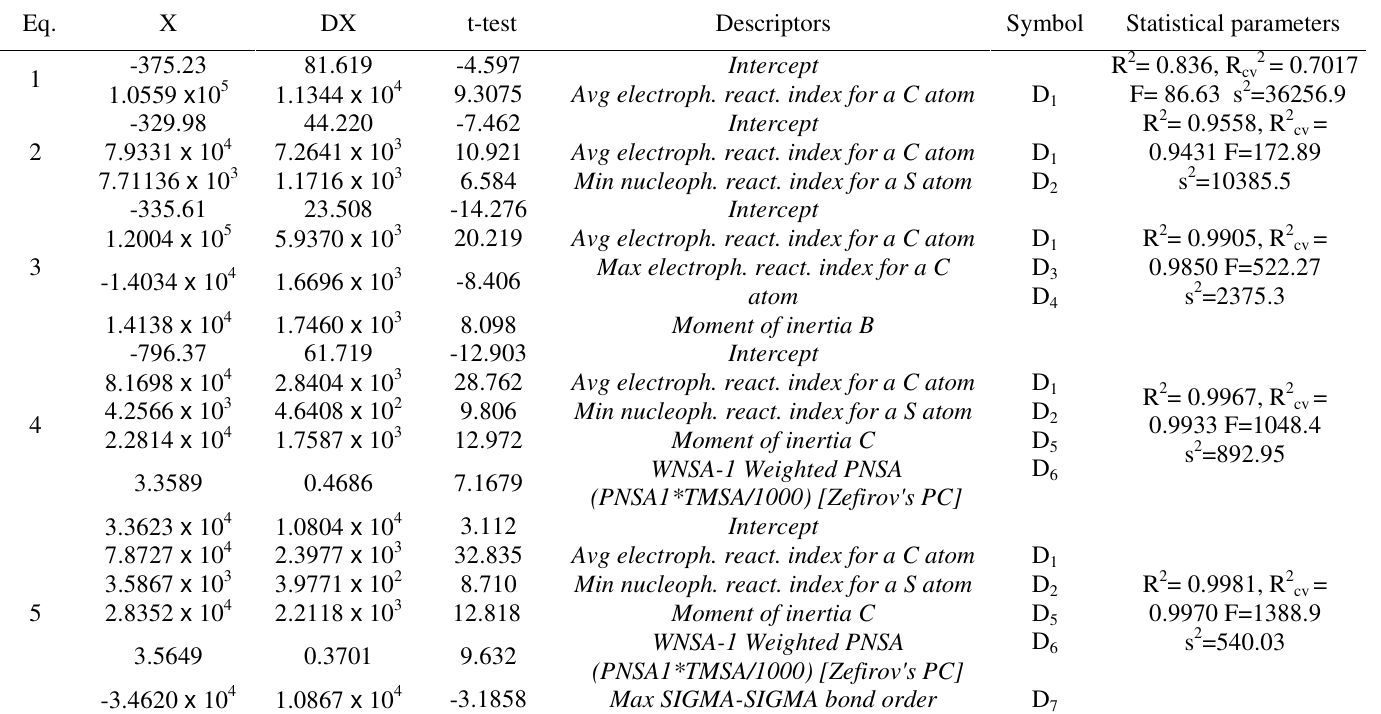
Table 1. QSAR models and statistical parameters of the correlations in the present study